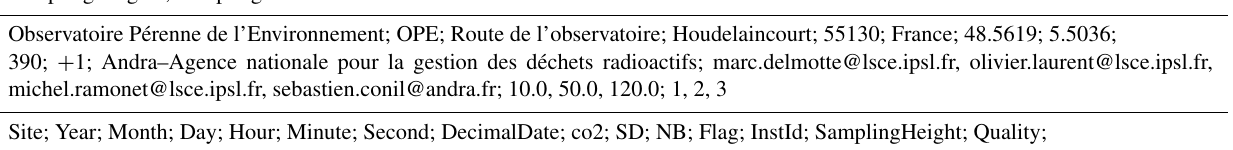
Table 7. Example of a file provided to the MACC-II project in near-real time (24h). The first block represents the metadata of the station, and the second block contains hourly means of CO 2 mole fractions in dry air for 1 day (Observatoire Pérenne de l’Environnement station, identified by the three-letter code OPE, instrument no.